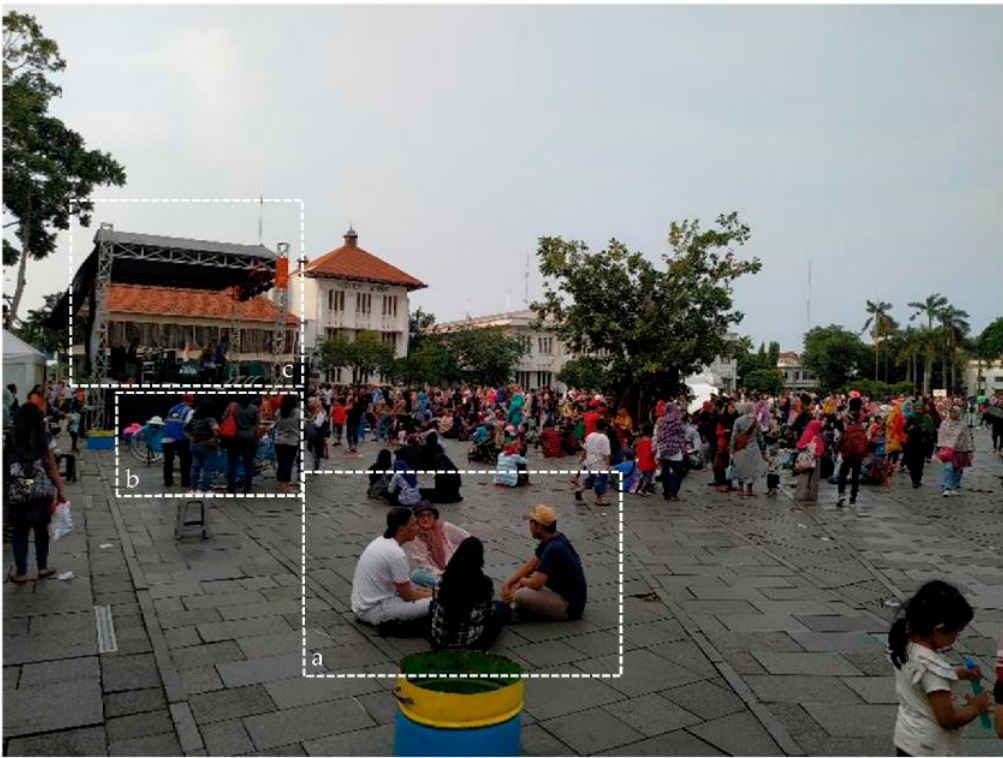
Figure 19. The condition of Fatahillah Square on weekends. Identified sound source in the picture: ( a )